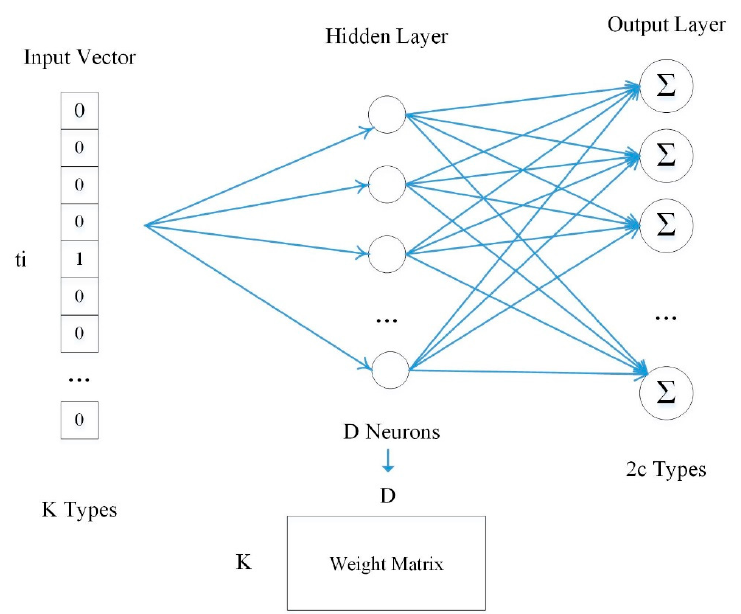
Figure 3. The Skip-Gram model. In the output layer, the input vector is the one-hot form where “1” represents the occupied position of the input type in the K types. In the hidden layer, D linear neurons are adopted and the D×K weight matrix of the neurons is the POI vector matrix. In the output layer, each output neuron uses a softmax classifier to predict the conditional probability of its context POI types, and the target is to minimize the loss.